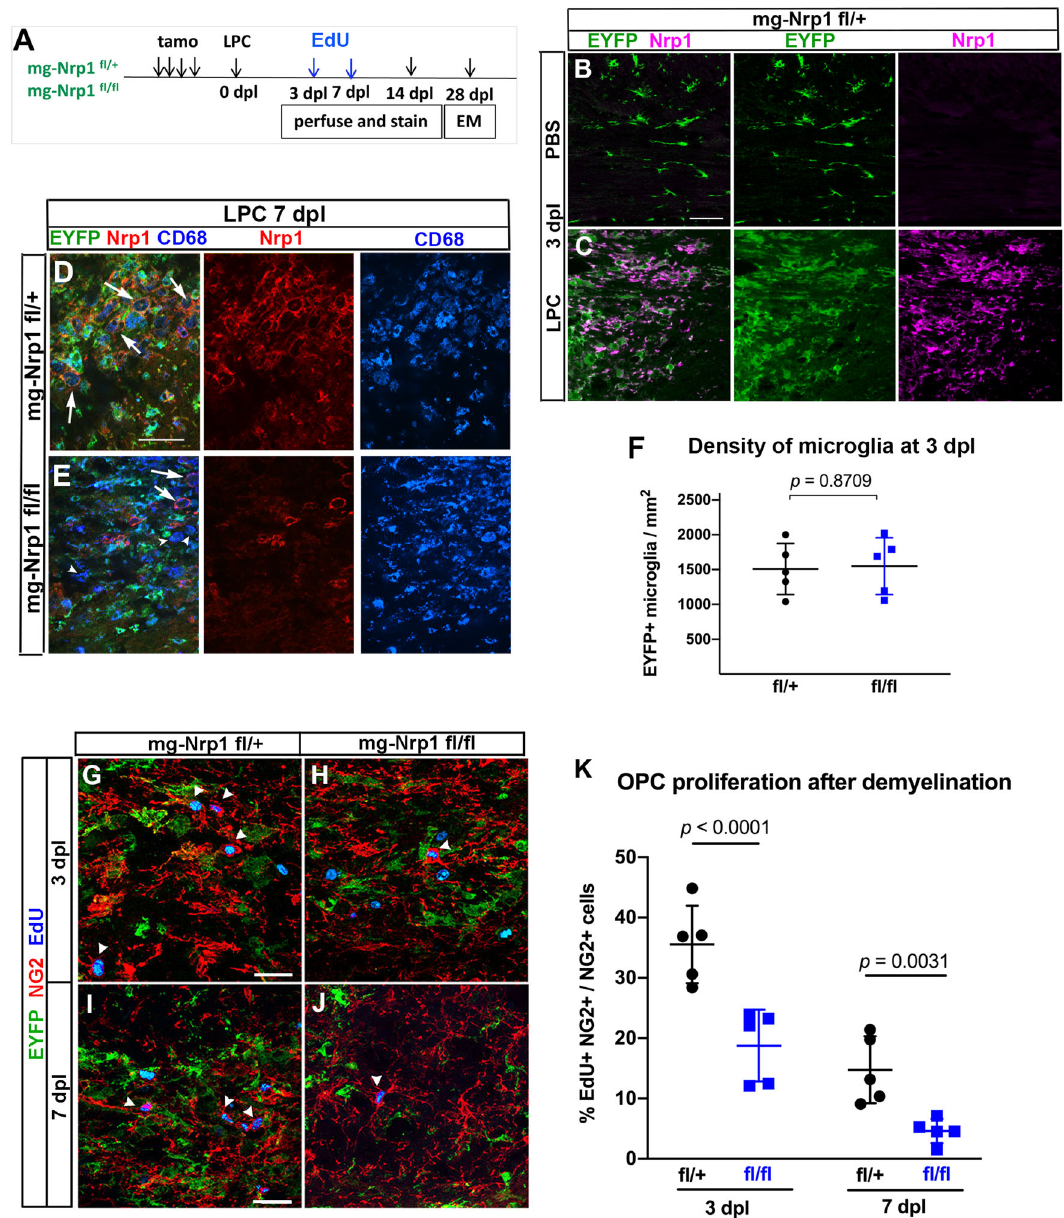
Fig. 4 Effects of mg-Nrp1-cko on OPC proliferation and myelin repair after demyelination. A Schematic of demyelination experiments. B , C Nrp1 (magenta) upregulation on EYFP + microglia/macrophages 3 days after LPC injection but not after PBS injection. Scale, 50 µ m. D , E Similar extent of CD68 (blue) expression and in fi ltration of activated microglia/macrophages into demyelinated lesion at 7 dpl in mg-Nrp1-cont ( D ) and mg-Nrp1-cko ( E ) mice. Red, Nrp1; green, EYFP. Arrows, Nrp1 + CD68 + macrophages; arrowheads, Nrp1-negative CD68 + cells. Scale, 50 µ m. F Quanti fi cation of the density of EYFP + microglia in the lesion at 3 dpl. Unpaired Student ’ s t -test, t = 0.1678, df = 8, n = 5. G – J Labeling for EdU (blue), NG2 (red), and EYFP (green) in mg- Nrp1-cont and cko mice sacri fi ced at 3 dpl after EdU pulse labeling. Arrowheads, NG2 + EdU + OPCs. Scale, 25 µ m. K Quanti fi cation of proliferating OPCs at 3 and 7 dpl in cont (black) and cko (blue) mice showing signi fi cantly lower extent of EdU incorporation into OPCs in mg-Nrp1-cko mice. OPC proliferation was higher at 3 dpl compared to 7 dpl for both genotypes ( p = 0.0007 for cont and p = 0.0351 for cko). Two-way ANOVA, Tukey ’ s multiple comparisons test, F (1, 16) = 54.70 for comparison between fl / + and fl / fl , F (1, 16) = 32.52 for comparison between 3 and 7 dpl, n = 5. Black circles, mg-Nrp1-cont; blue squares, mg-Nrp1-cko in F and K . Source data are provided as a Source Data fi